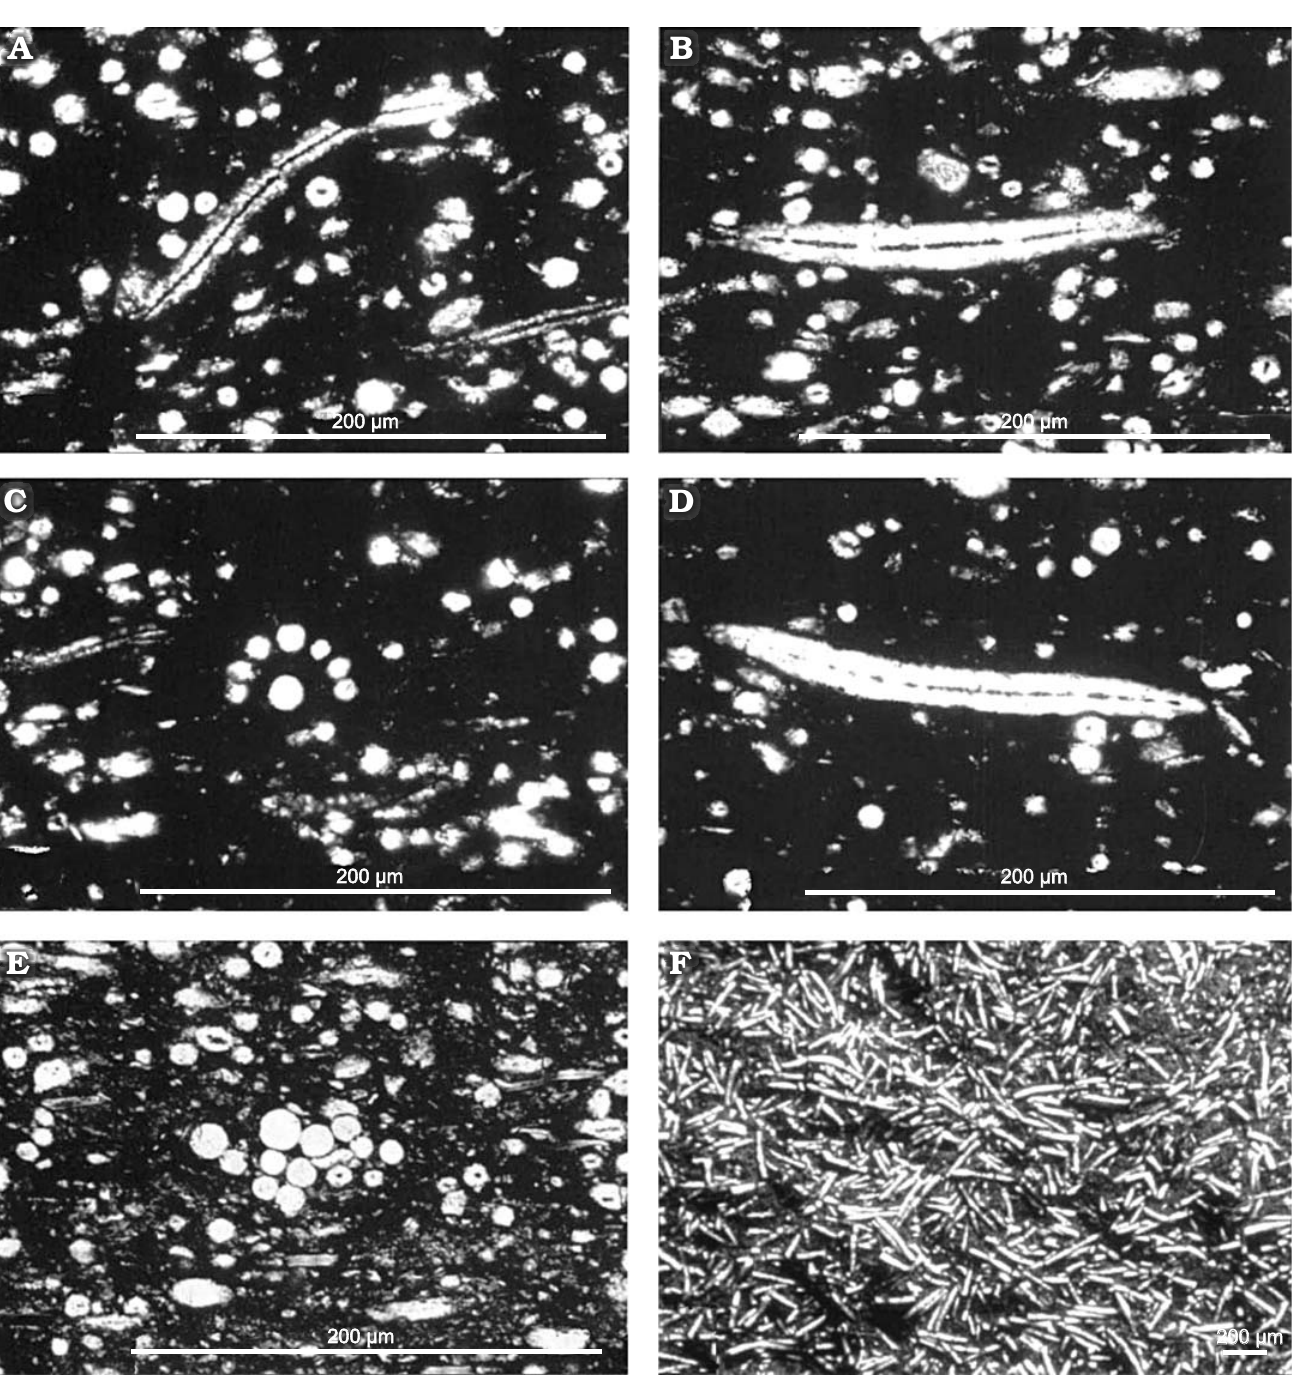
Fig. 10. Spongillida gen. et sp. indet. sensu Schindler et al. 2008. Stefanian-Autunian, Permo-Carboniferous, Donnersberg, Friedelhausen, Saar-Nahe Basin, Germany. Thin section of spiculite from the site Lemberg/Saar-Nahe Basin, layer 4 (PWL2004/5035a-LS). A . Longitudinal and cross sections of slim oxeas with axial canal. B . Thick oxea with axial canal. C . Concentric spicule bundle. D . Slim oxea with axial canal. E . Radially arranged spicule bundle. F . Layer surface (find from stockpile) etched with hydrofluoric acid (PWL2004/5039-LS). Modified from Schindler et al.